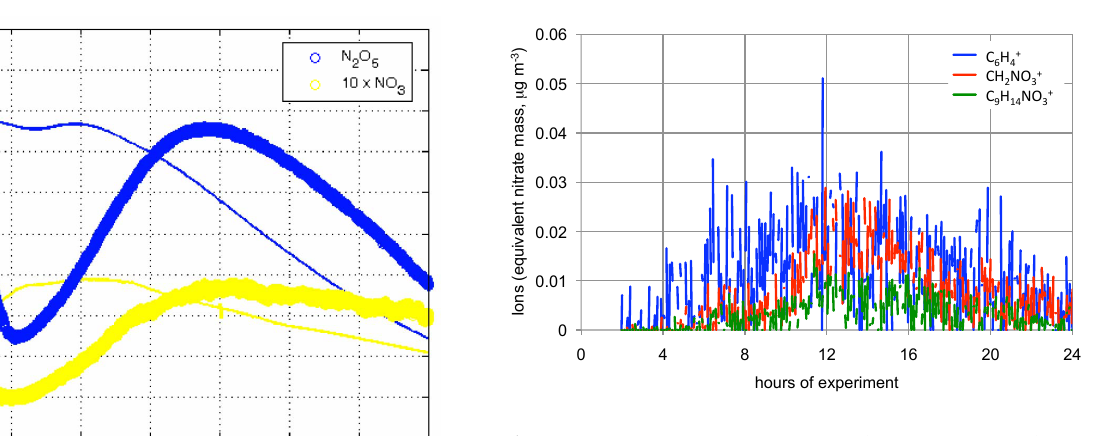
Fig. 8. AMS-detected organo-nitrates fragments. For reference, Fig.8. AMS-detectedorgano-nitratesfragments. Forreference,C 6 H 4+ isalsoshown,afragmentwhichoccurs C 6 H 4 + is also shown, a fragment which occurs at the same nominal at the same nominal m/z as CH 2 NO 3+ . m/z as CH 2 NO 3 +